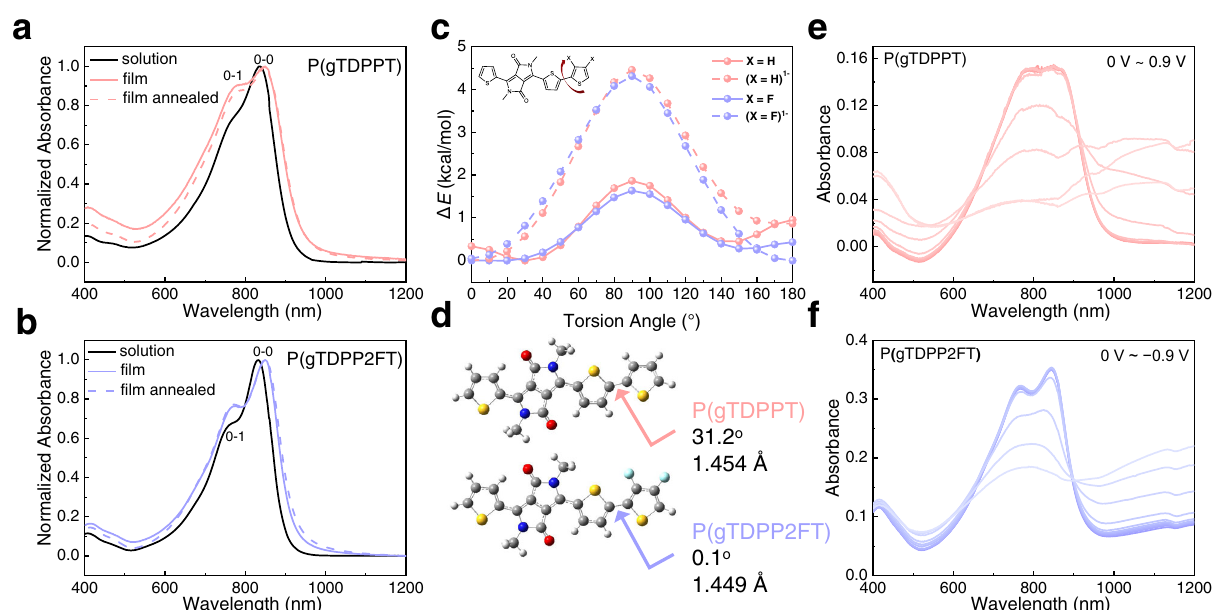
Fig. 2 | Optoelectronic properties of both polymers. Normalized UV-vis-NIR absorption spectra of a P(gTDPPT) and b P(TDPP2FT) in chlorobenzene (CB) solution, inathin fi lm, and annealed fi lm onglass(80°C, 10min). c Comparison of the relaxed PES scans of the dihedral angles for the monomers of P(gTDPPT) and